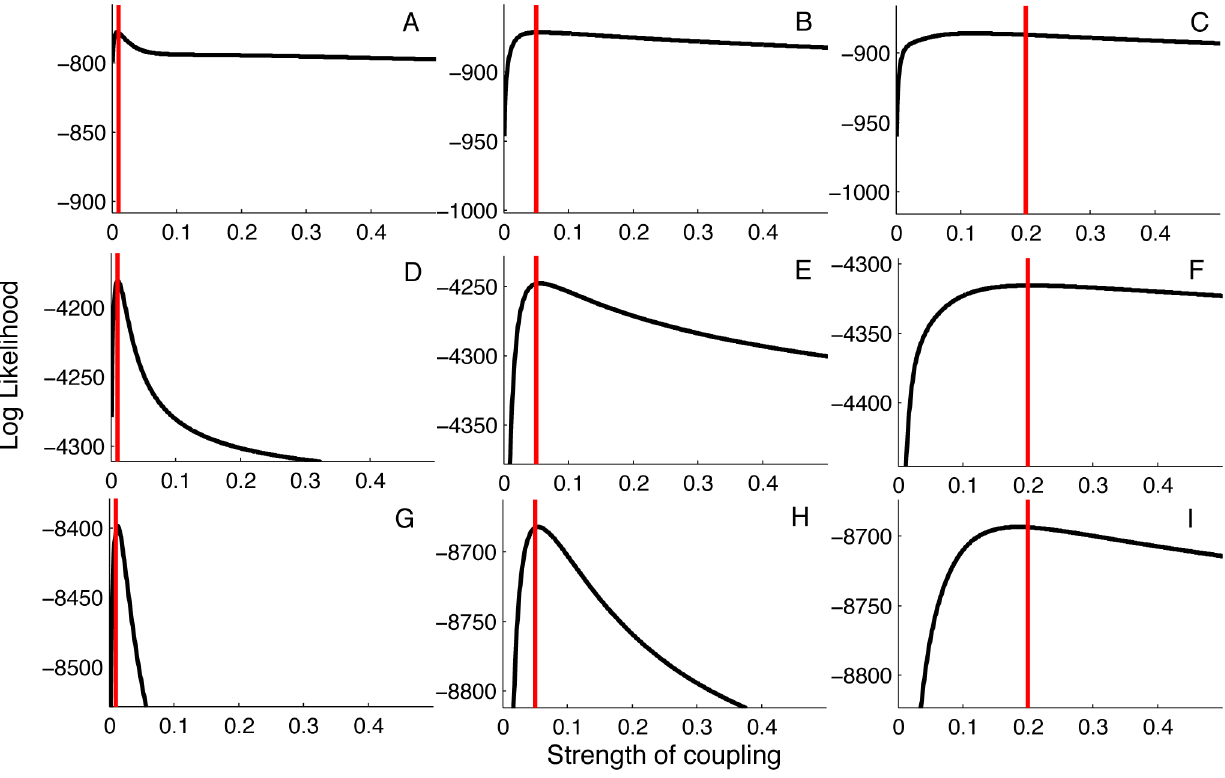
Figure 6. Likelihood profiles for the strength of coupling r obtained from genealogies simulated under different values of r . Red lines correspond to the true value of r . The likelihoods were computed from genealogies with 100 samples in (A–C), 500 samples in (D–F) and 1000 samples in (G–I). These sample sizes correspond, respectively, to approximately 0.2%, 1.0% and 2% of all infected individuals being sampled.